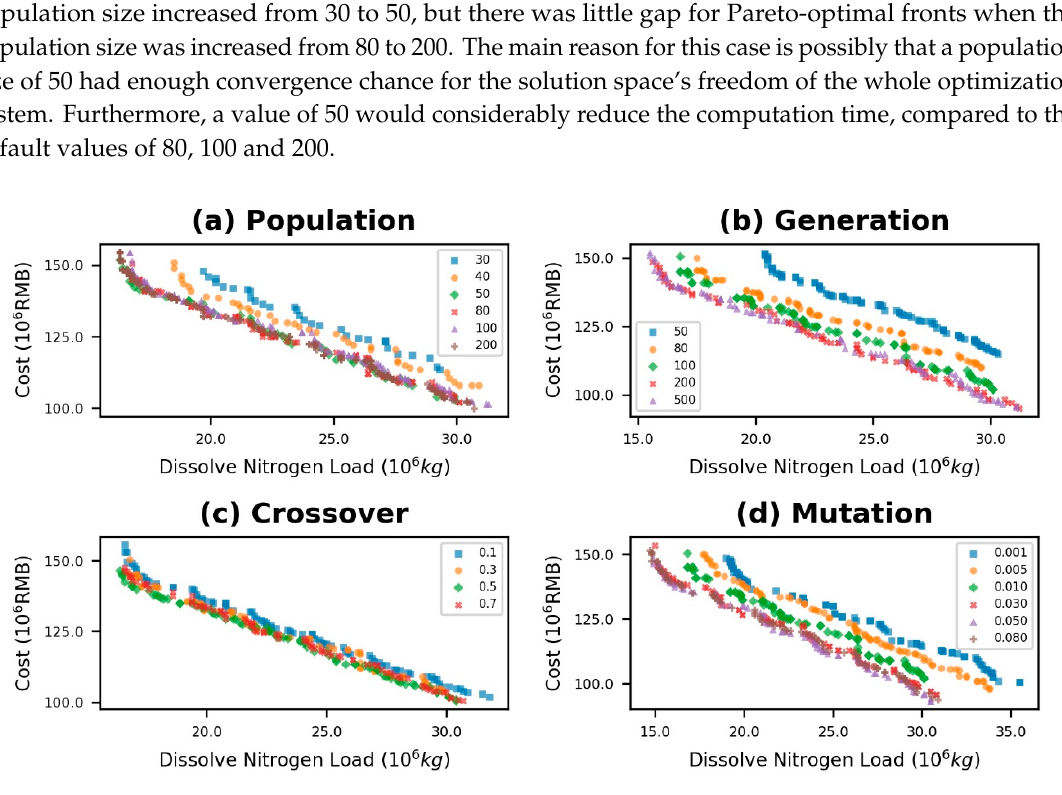
Figure 5. Pareto-optimal fronts for the sensitivity analysis of NSGAII.